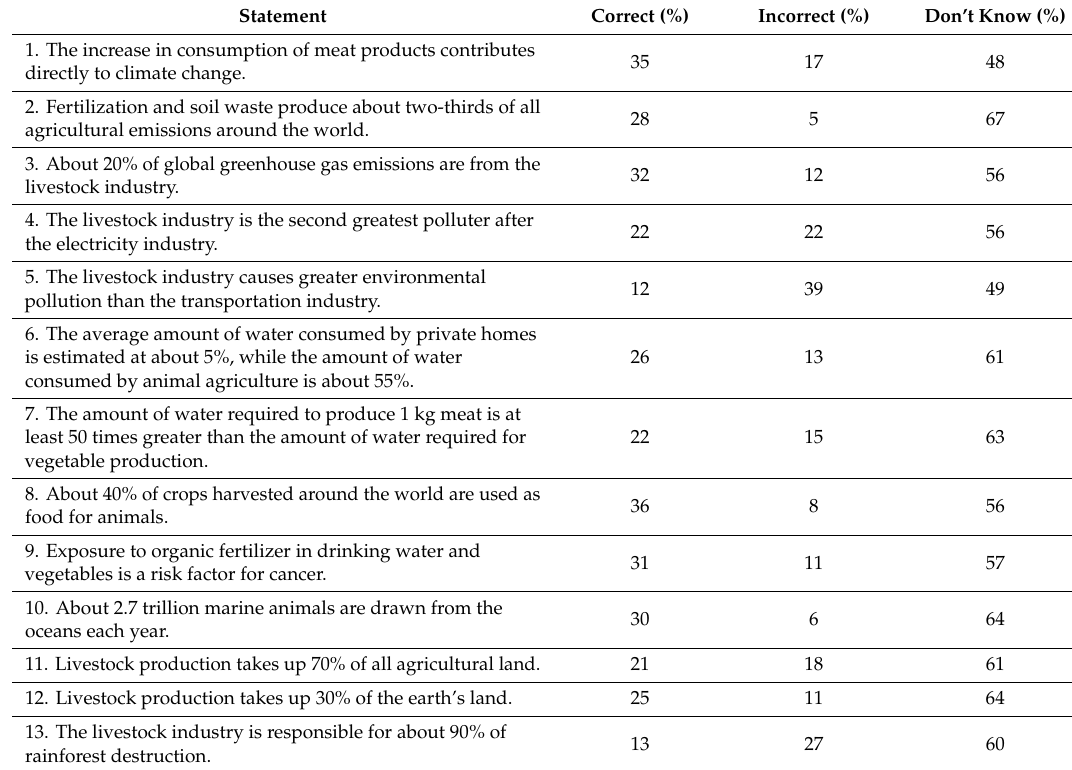
Table 2. Distribution of responses to the knowledge